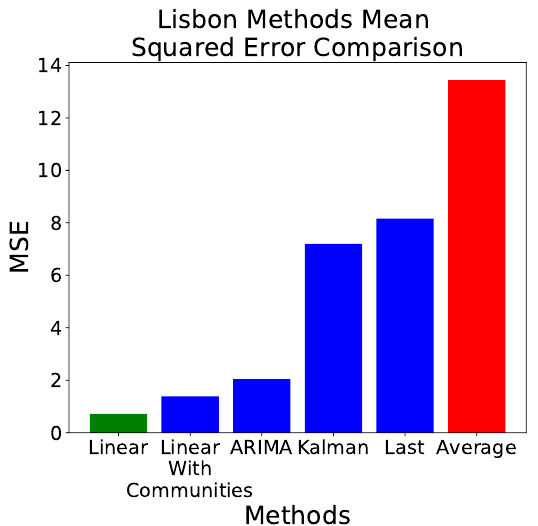
Figure 6. Error, measured as MSE , obtained by the six considered forecasting methods, when applied to the Lisbon’s temperature data set. The red and green bars respectively indicate the worst and best prediction